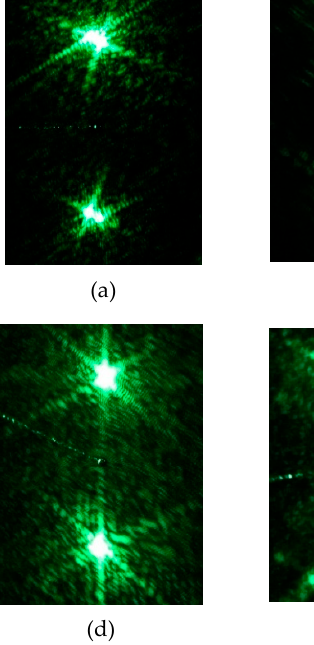
Figure 22. Comparison of the coefficient of luminous intensity R I between the commercial sample and the optimized prototyped sample (region by region). 5. Conclusions and Discussions A new optimal CCCR design which improves the performance and working area of the previous commercial one is proposed. We have demonstrated that the parameter of height difference between pin groups in a CCCR unit has an impact on the reflected light performance. In experiments, the curved retroreflector with a 120 × 28 mm reflecting area was built by 15 arrays of double-pin groups, and each pin cross-section size is 5.56 mm. It is demonstrated that a SuperPin CCCR can retro-reflect one incident beam as six beams, as shown in Figure 5c. If a CCCR has a curved region, the height between each group of pins due to surface curvature would affect optical characteristics, leading to lower reflection efficiency and even failing to pass ECE regulations. By using double-pin groups to build the primary SuperPin CCCR, reflection efficiency can be improved. Through using OptisWork software to find out the optimized SuperPin CCCR, R I can be increased further, but by sacrificing reflection efficiency R A , as shown in Figures 18 and 19. Using an efficient working area ratio, reflection efficiency R A and coefficient of luminous intensity R I as the evaluation indices of CCCR to compare a commercial SuperPin CCCR with the proposed new design, it can be inferred that the optimized